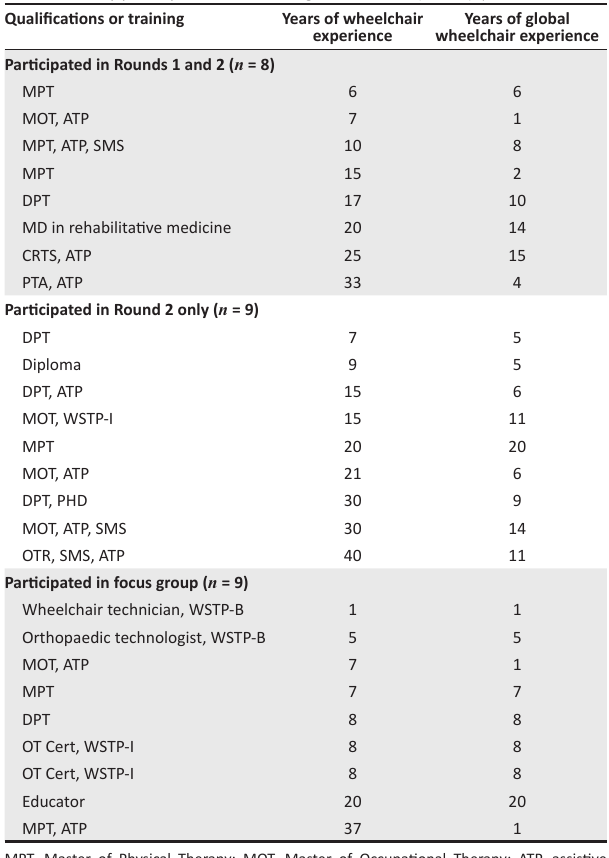
TABLE 1: Study participants for each stage of research ( n = 24).